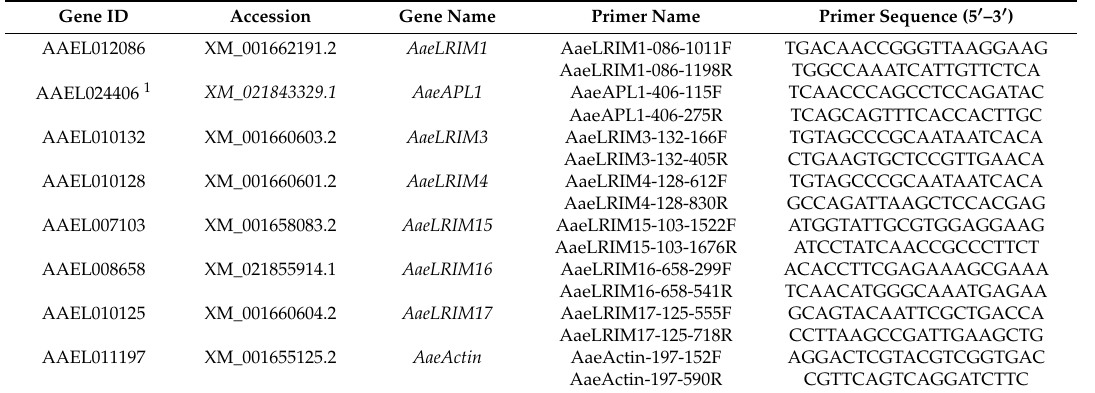
Table 6. Primers from Aedes aegypti for qPCR